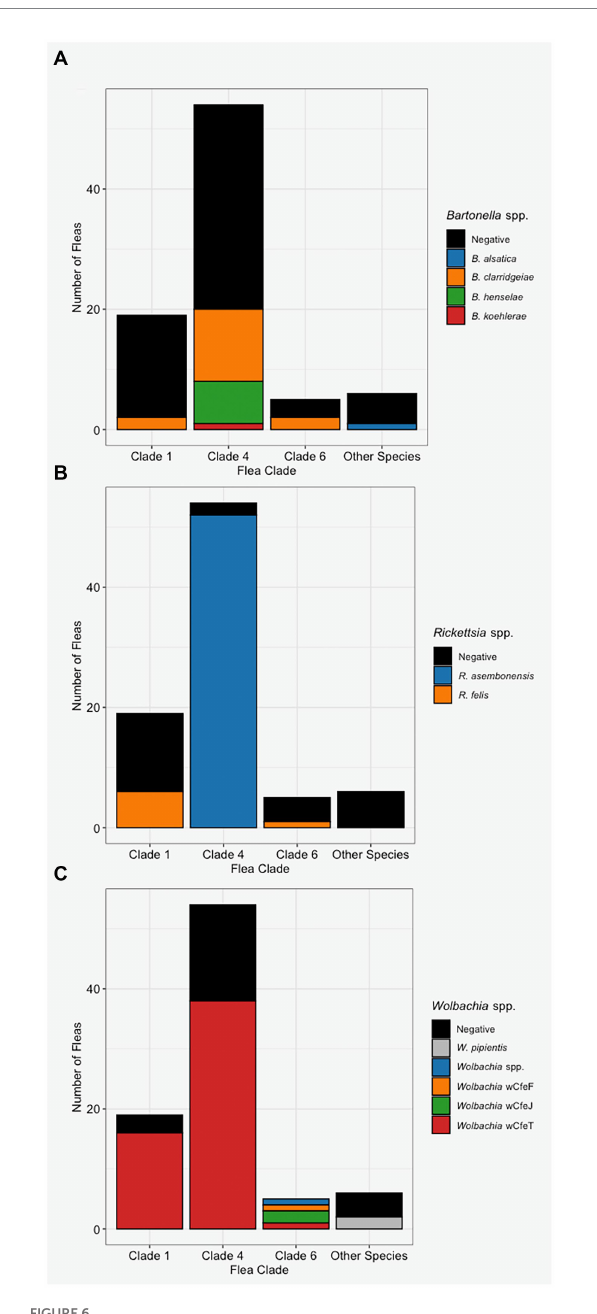
FIGURE 6 The Bartonella (A) , Rickettsia (B) , and Wolbachia (C) infection status of fleas based on their assigned clade or species ( x -axis).